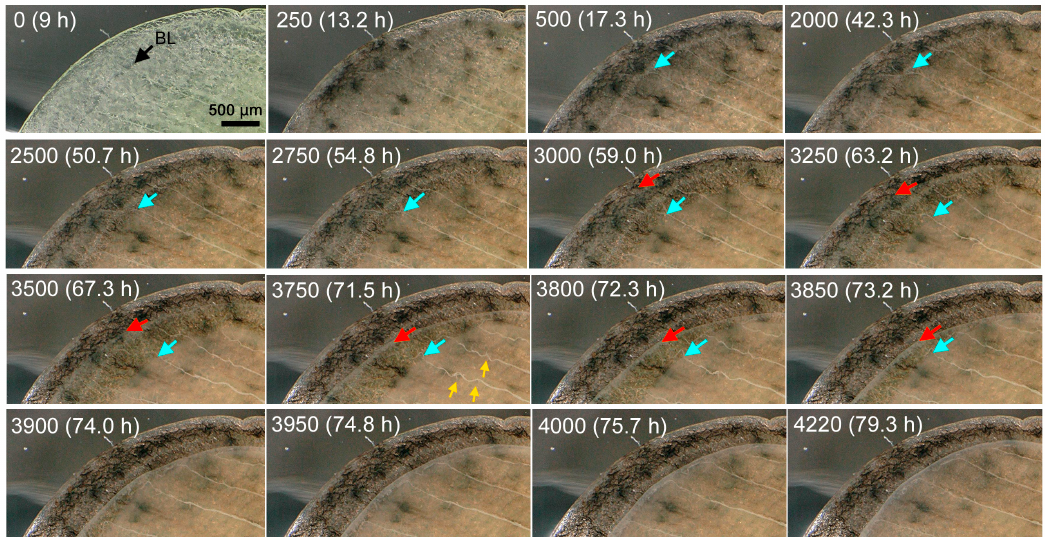
Figure 5. Dynamics of a distal area of the pupal forewing (enlarged images from Figure 4). BL in the panel IN0 indicates the bordering lacuna. The edges of the ventral forewing (blue arrows) and those of the dorsal forewing (red arrows) are indicated. The loosened tracheae are indicated by yellow arrows in IN3750.